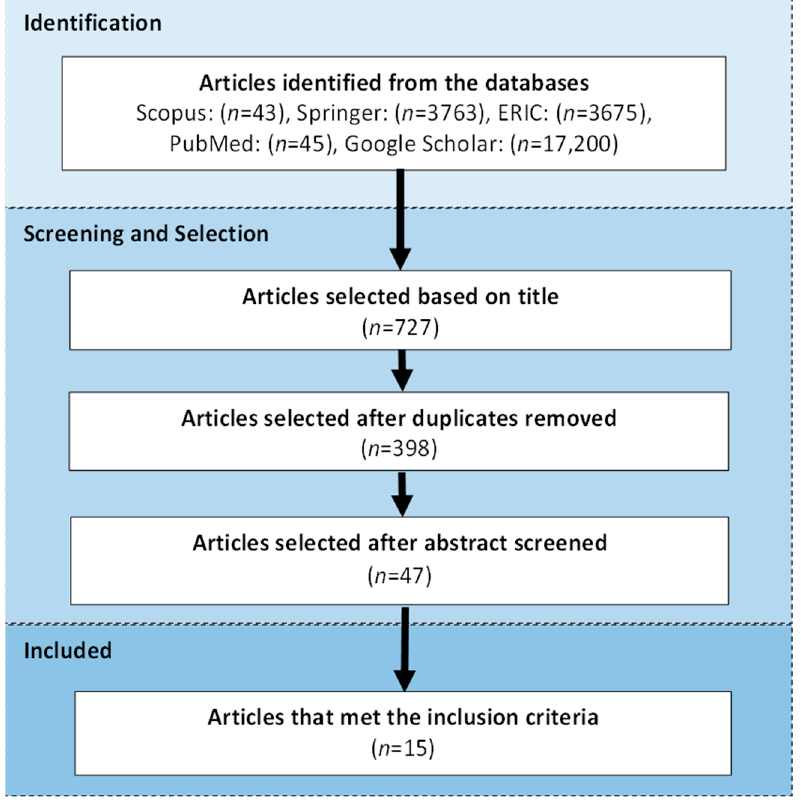
Figure 1. The searching and selection process.